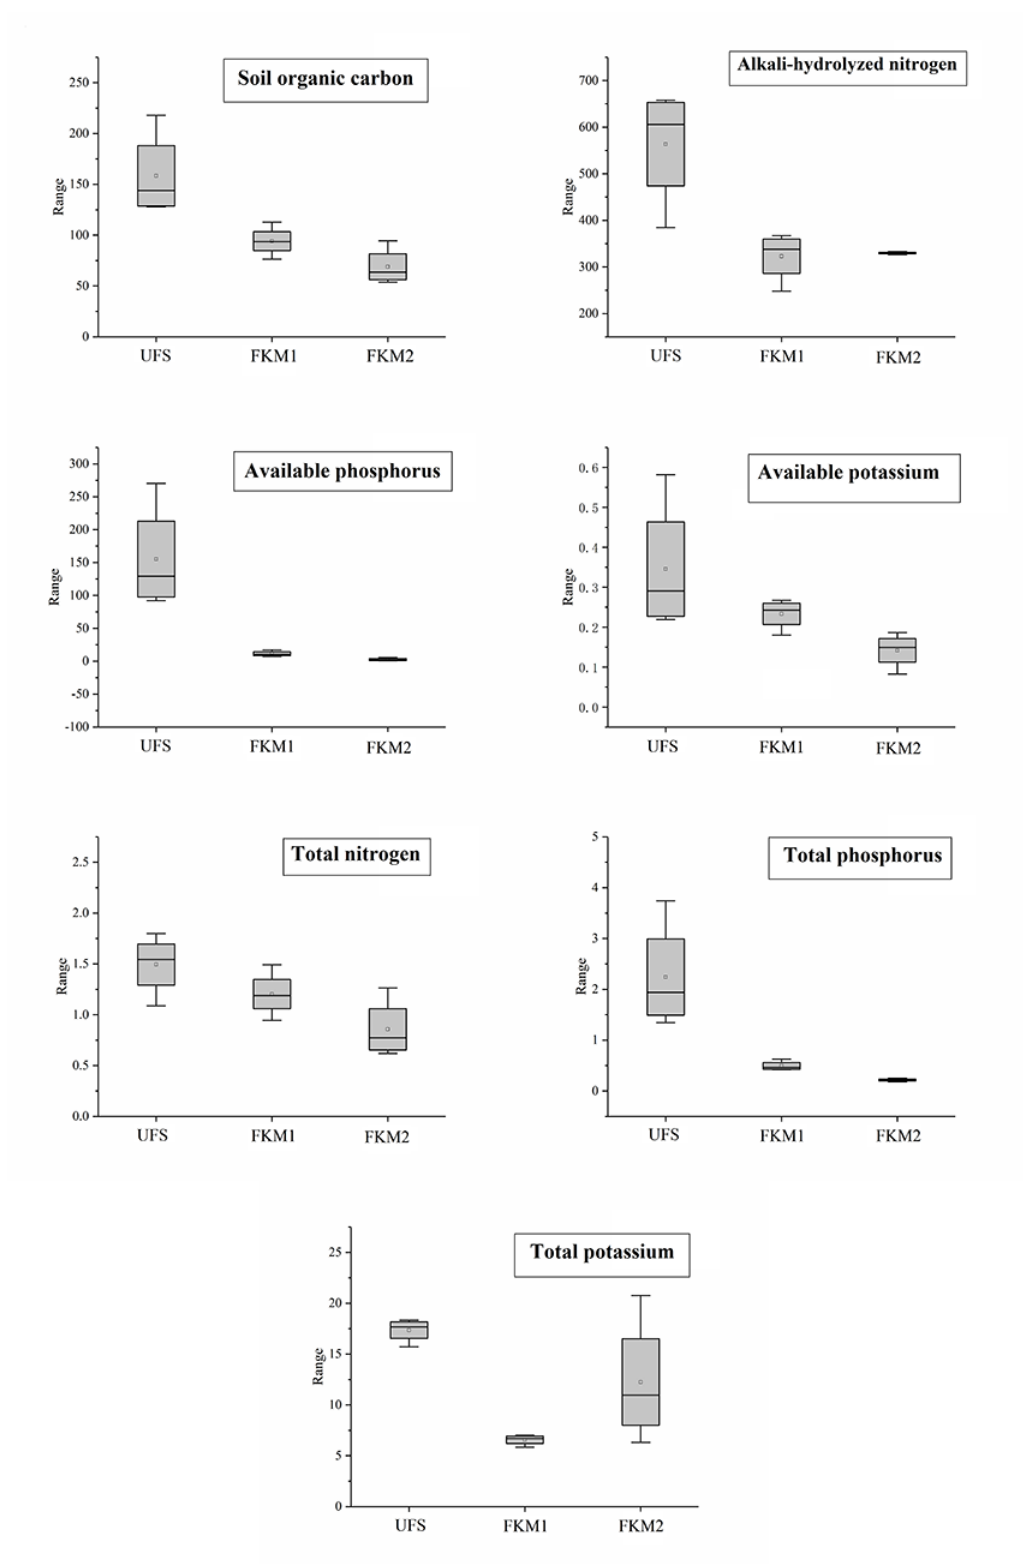
Figure 6 Soil nutrients: soil organic carbon, total nitrogen, total phosphorus, total potassium, alkali-hydrolyzed nitrogen, available phosphorus, and available potassium in the sinkhole forest (UFS) and the two surface forests (FKM1 and FKM2). Bottom and top sections ofthe box plots indicate the inner quartile ranges. The horizontal bar within the box represents the median. Whiskers indicate